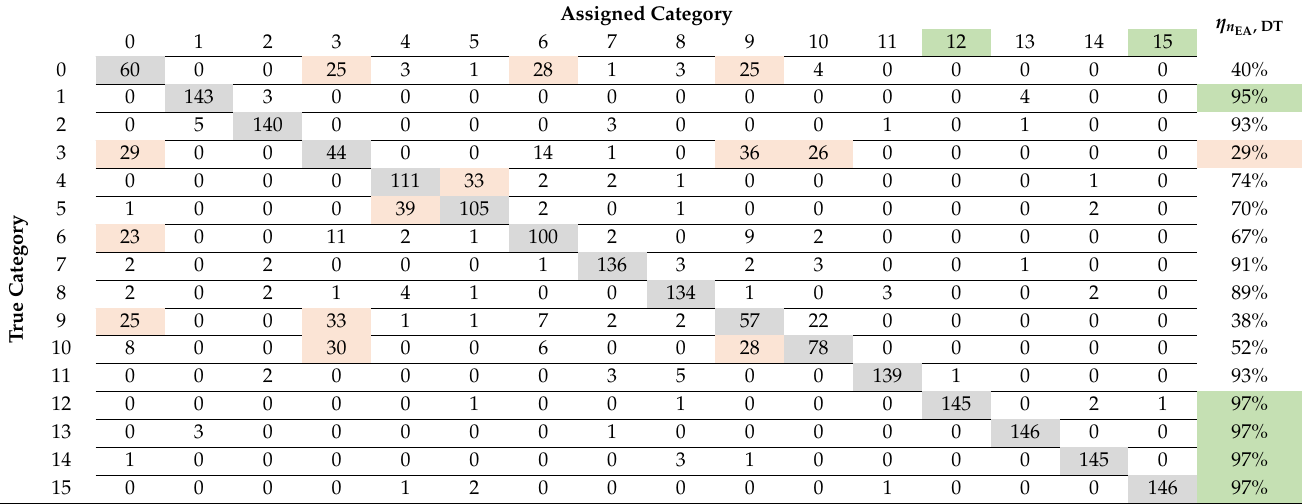
Table 5. Confusion matrix and classification accuracy for the decision tree